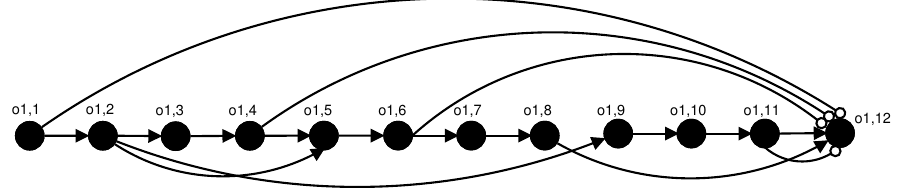
Figure 6. A subgraph representing the code from Figure